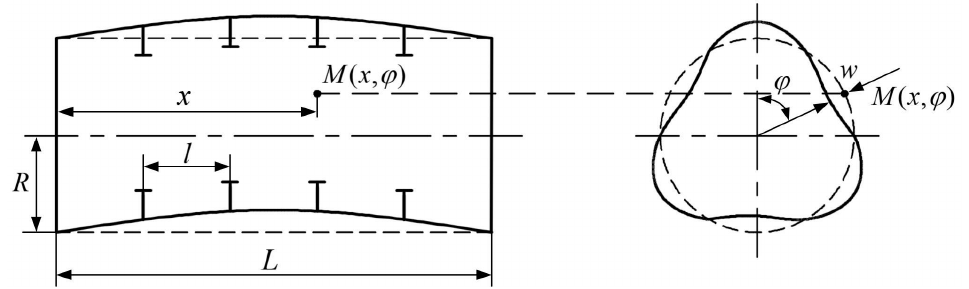
Figure 6. The coordinate system for rib stability analysis.